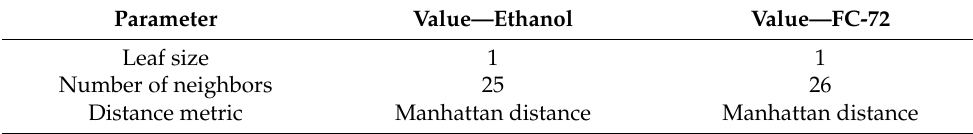
Table 6. Optimal hyperparameters for K-nearest neighbors classifier.